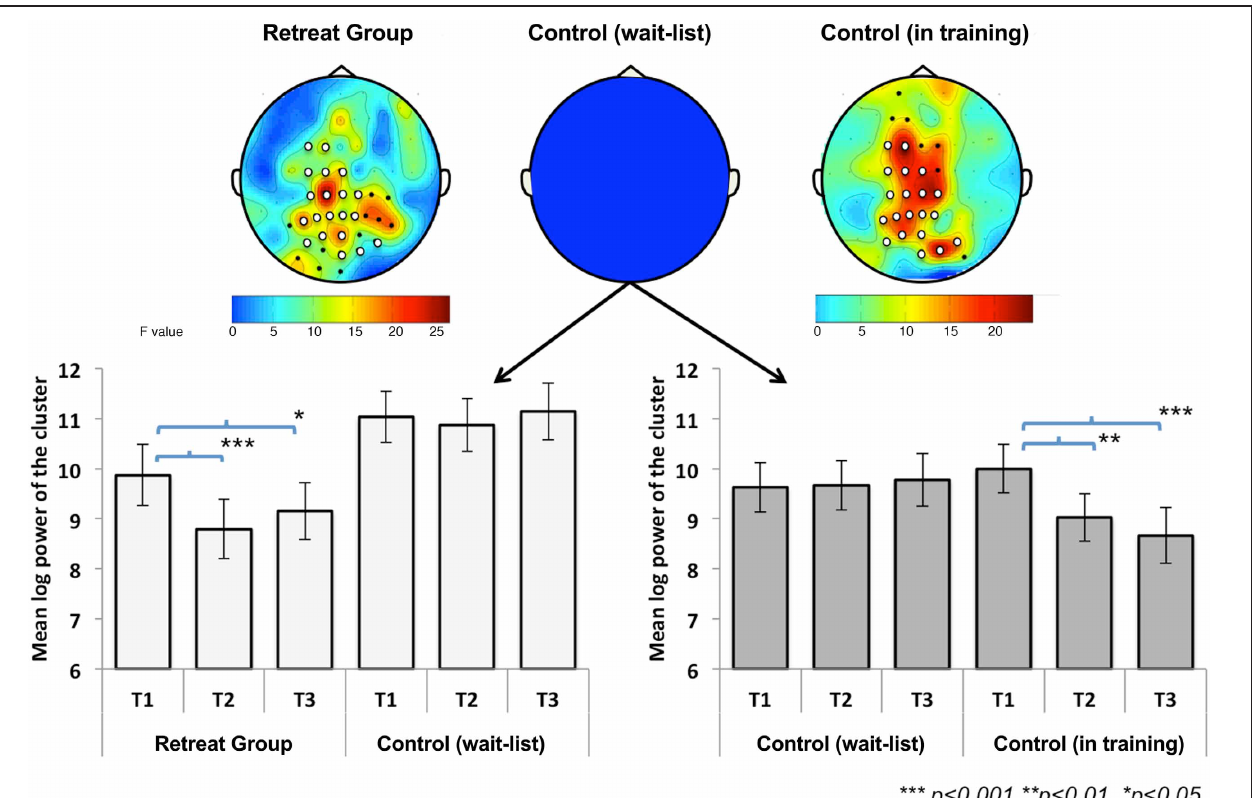
FIGURE 3 | Change in mean beta-band (1.2 × α IAF − 30Hz) log power [( μ V/m 2 ) 2 /Hz] across assessments during Retreat 1 (left panel) and Retreat 2 (right panel). Error bars are reported as standard errors of the mean. Significant bilateral anteriocentral and posterior clusters were found in both retreat groups. No significant clusters were found for the